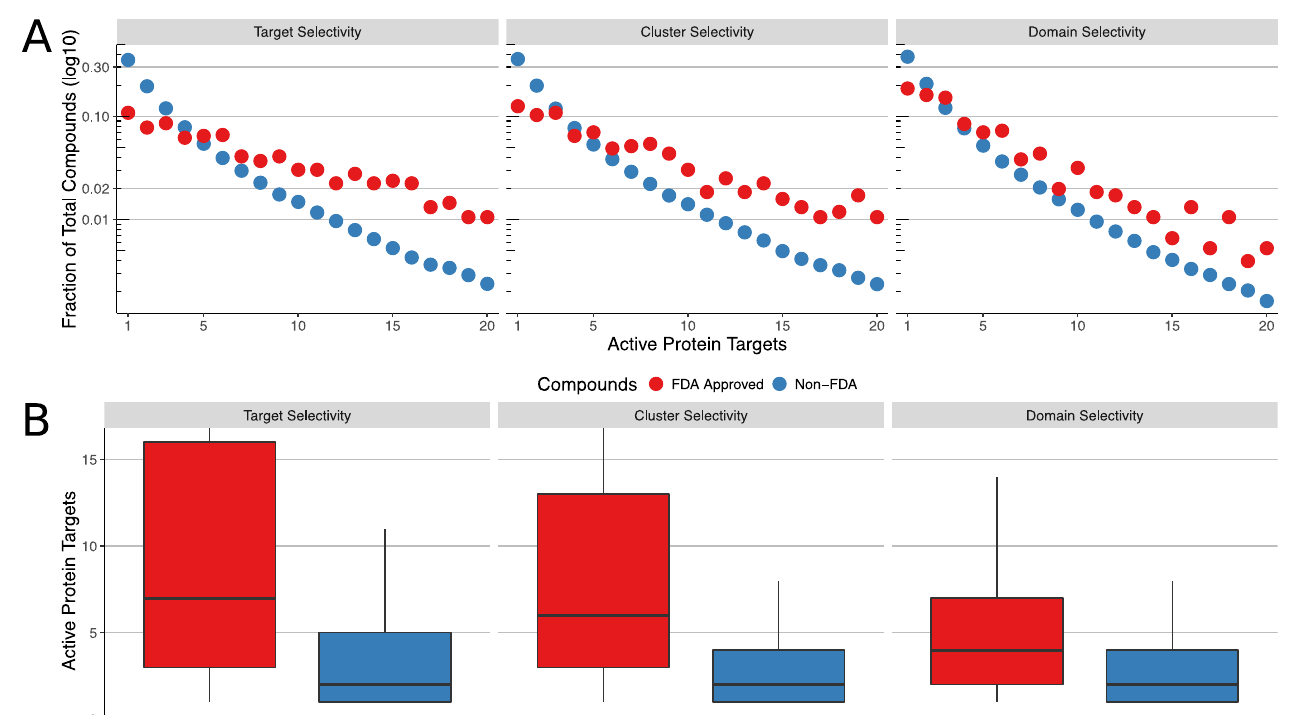
Fig 4. Distribution of active proteins per compound. Both plots show the distributionof target selectivity amongPubChemBioAssay compounds,with selectivity quantifiedby three methods which cluster protein targets across increasingly large evolutionary distances, as describedin the text. FDA approved drugs (red) are shown separately from non-FDA approved compounds(blue). (A) Semi-log plot of the target selectivity distributions,where horizontal (x) axis represents the number of active protein targets and/or protein target clusters, while the vertical (y) axis represents the fraction of each compoundset that is active against a particular number of targets. (B) Box plot of the target selectivity distributions, with horizontallines at the 25%, 50%, and 75% quantilesfor each distribution.The vertical (y) axis representsthe number of active protein targets and/or protein target clusters. Whiskers extend to 1.5 times the inter-quartilerange, however we limit the vertical (y) axis to 16 in order to zoom into the higherdensity region.